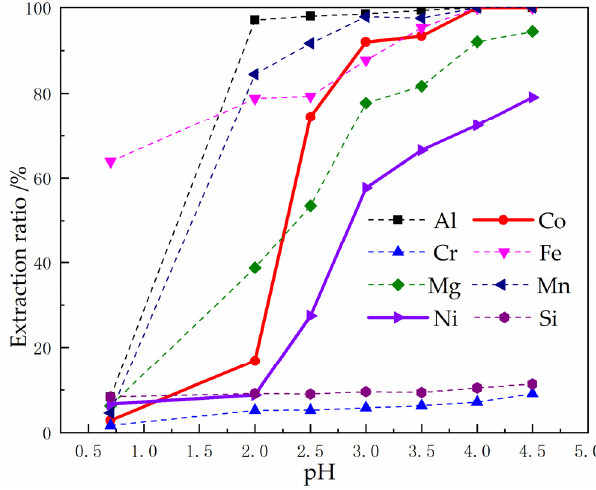
Figure 9. Effect of pH on the extraction of metals with P507. Figure 9. E ff ect of pH on the extraction of metals with